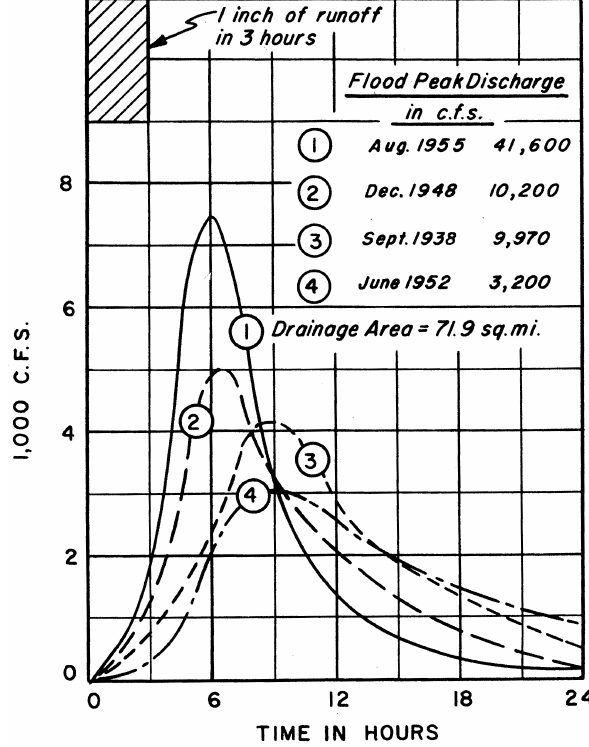
Fig. 2. The Childs family of unit hydrographs for the Naugatuck River in Connecticut, USA. (Reprinted with permission of